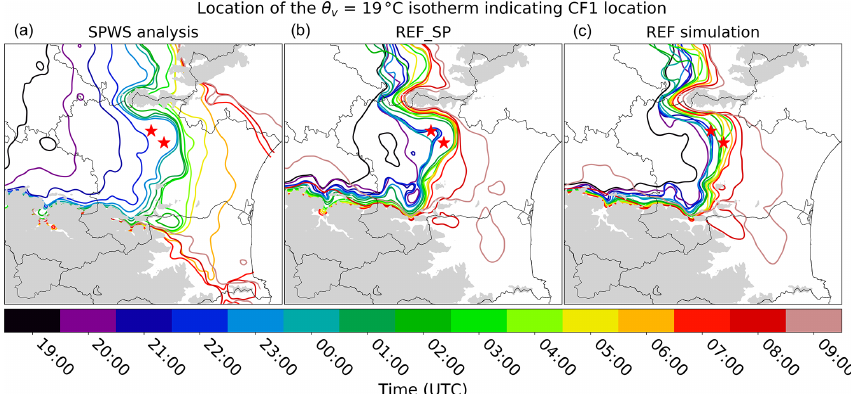
Figure 8. Location of the 19 ◦ C virtual potential temperature ( θ v ) isotherm at 2m height between 19:00UTC on 14 October and 09:00UTC on 15 October from (a) the SPWS analysis, (b) REF_SP and (c) the REF simulation. Terrain elevations above 750ma.s.l. are shaded in grey. Red stars are as in Figs. 1 and